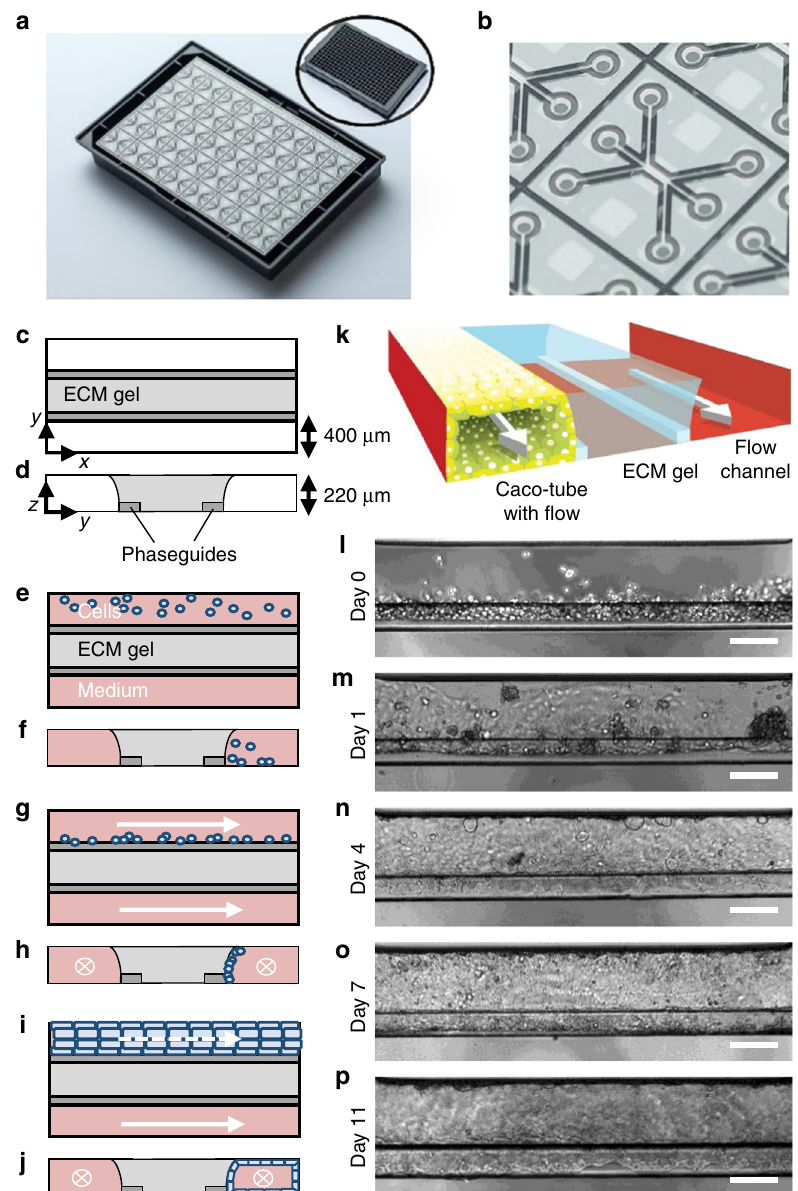
Fig. 1 Overview of the method for modeling intestinal tubules in the OrganoPlate platform. a Photograph of the bottom of an OrganoPlate showing 40 micro fl uidic channel networks with inlay showing the top view of the 384-well plate format device; b Zoom-in on a single micro fl uidic channel network comprising three channels that join in the center. c , e , g , i Horizontal projection and d , f , h , j vertical cross section of center region for subsequent steps in establishing the gut model. c , d An extracellular matrix gel ( light gray ) is patterned by two phaseguides ( dark gray ), e , f culture medium is introduced in the two lanes adjacent to the ECM gel, one of which comprises cells. g , h Cells are allowed to settle against the ECM gel surface by placing the plate on its side. i , j Upon application of fl ow, cells form a con fl uent layer lining the channel and gel surfaces, resulting in a tubular shape. k 3D artist impression of the center of a chip comprising a tubule, an extra cellular matrix gel and a perfusion lane; two phaseguides ( white bars ) are present that de fi ne the three distinct lanes in the central channel. The tubule has a lumen at its apical side that is perfused. l – p Phase-contrast images of the formation of the tubular structure at day 0, 1, 4, 7, and 11, respectively. Scale bars are 100 µ